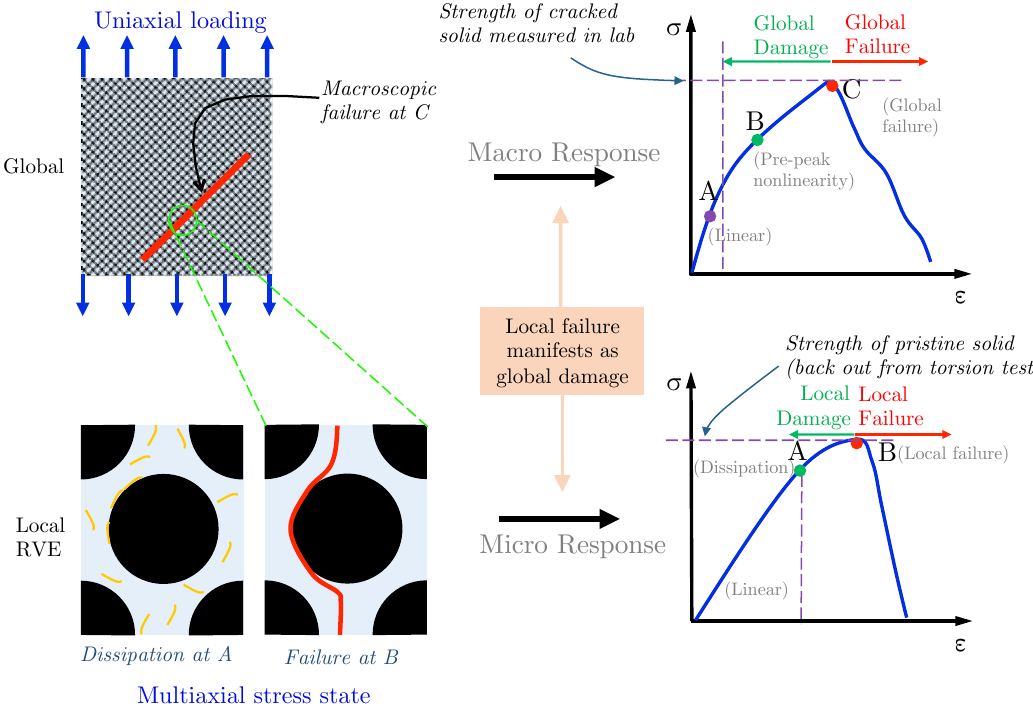
Figure 1. Qualitative behavior of the fiber matrix specimen (global) under uniaxial loading in contrast to behavior of fiber-matrix (local) constituents at the